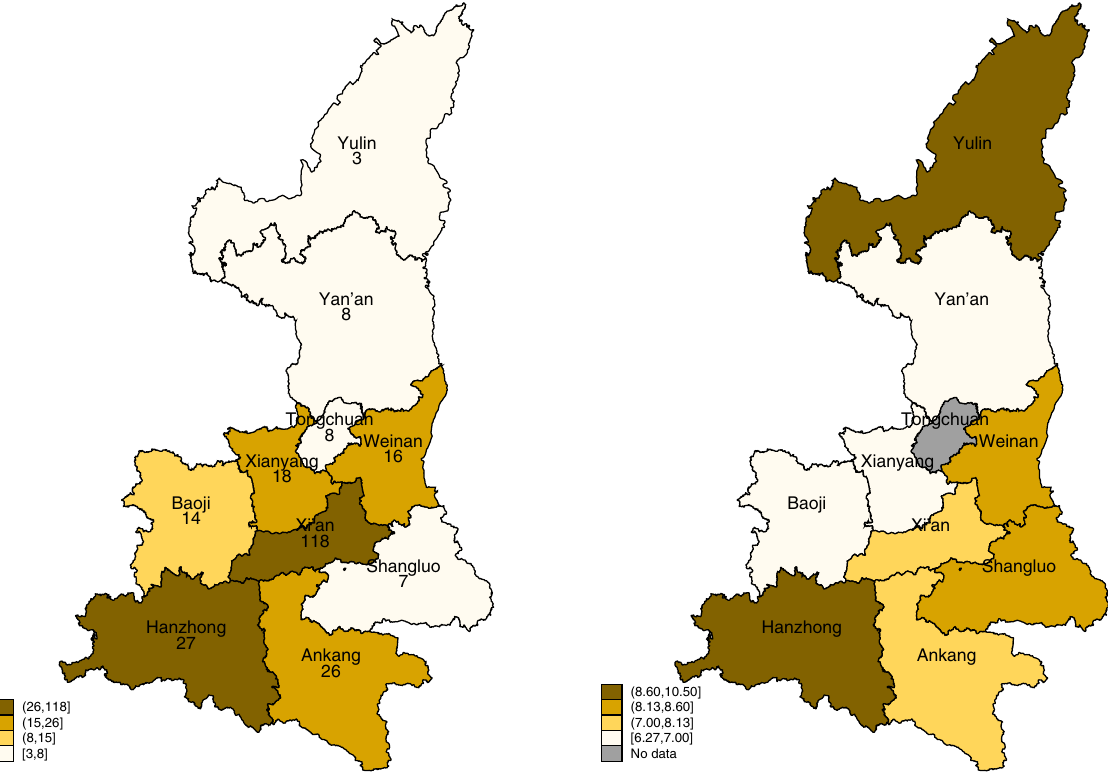
Figure 1. Number of COVID-19 cases and time to diagnosis in the province of Shaanxi, China. Note: Cases are collected from January 23rd to February 20th, 2020. Statistics are aggregated at the prefecture level,